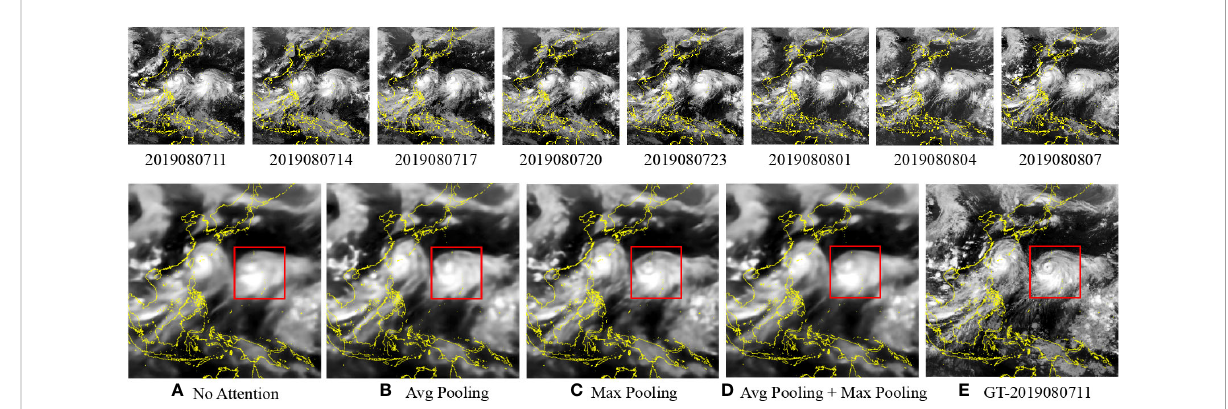
FIGURE 8 Visual results of adding the channel attention module with different pooling methods; the second row displays the outputs. (A) without channel attention; (B) using average pooling; (C) using maximum pooling; (D) combining average pooling and maximum pooling; and (E) ground truth.